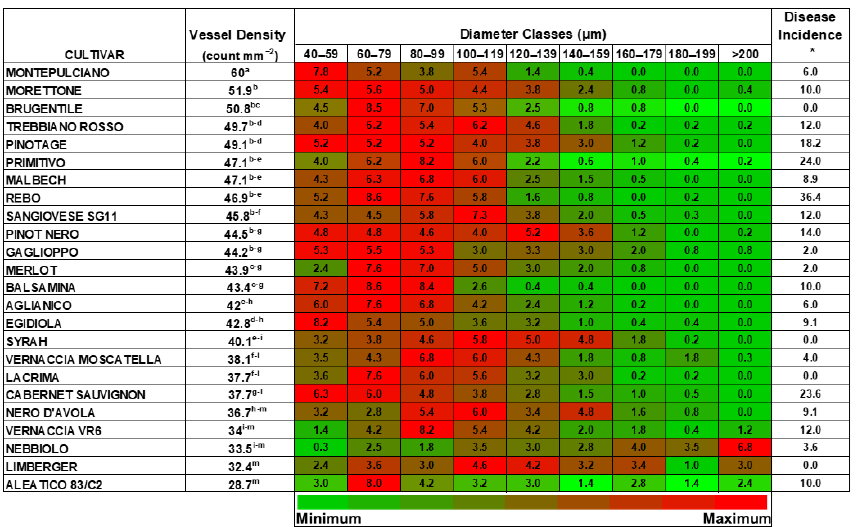
Figure 6. Quantification of vessel density and distribution per diameter class (vessels/mm 2 ) for the 24 red-berried grapevine cultivars. The differentiation in colour defines the minimum (light green) to maximum (light red) values. Different letters above columns indicate significant differences between cultivars (Fisher tests; p ≤ 0.05). *, esca incidence.